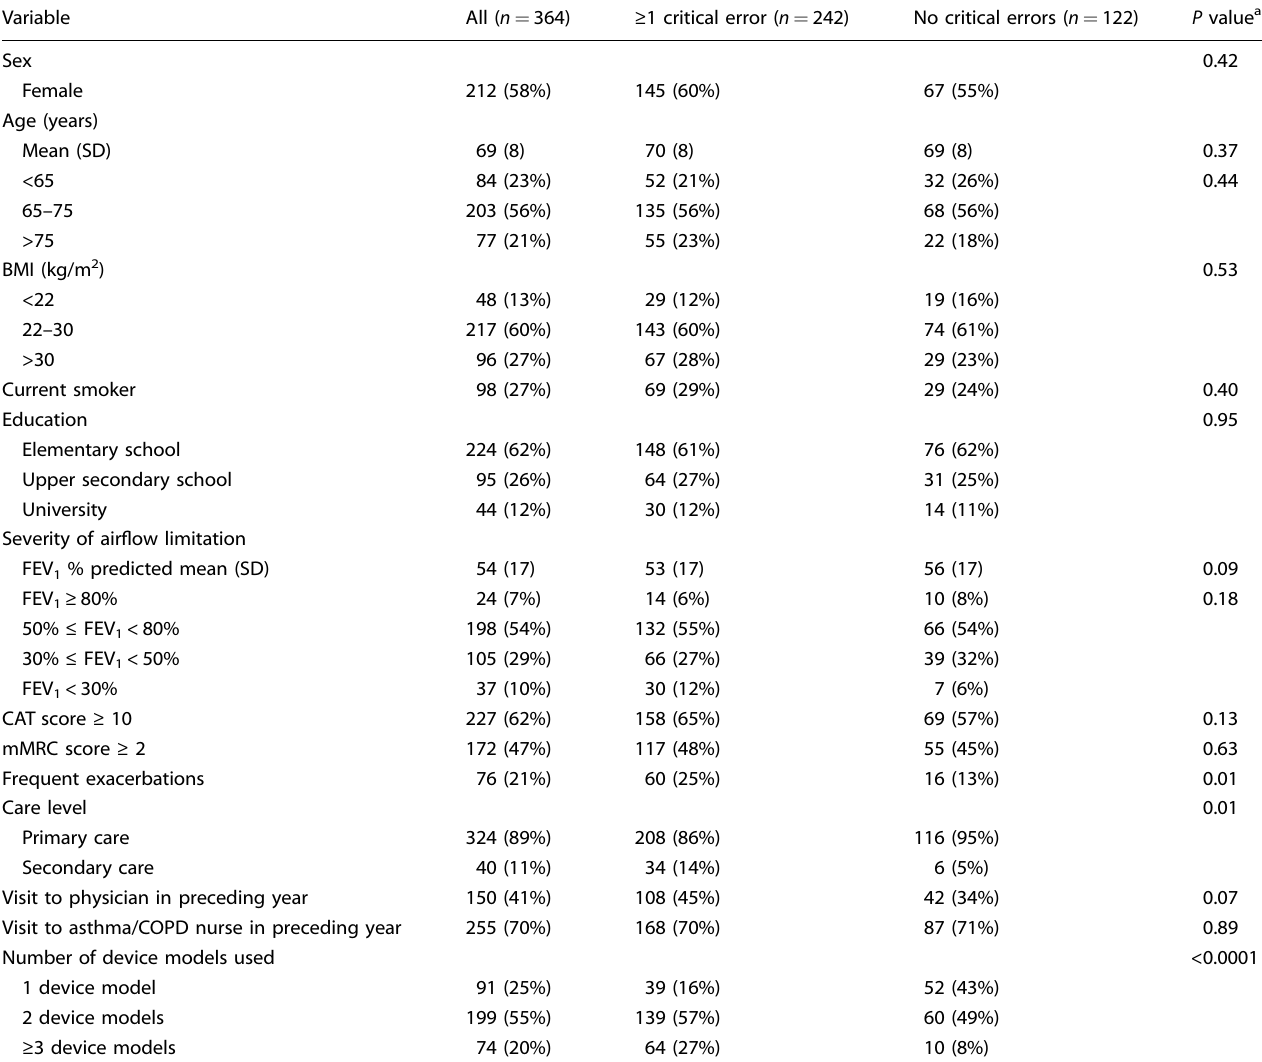
Table 1. Demographics and study characteristics of the patients included in the assessment of critical errors, and for the subgroups of patients making ≥ 1 critical error and patients making no critical errors with at least one device